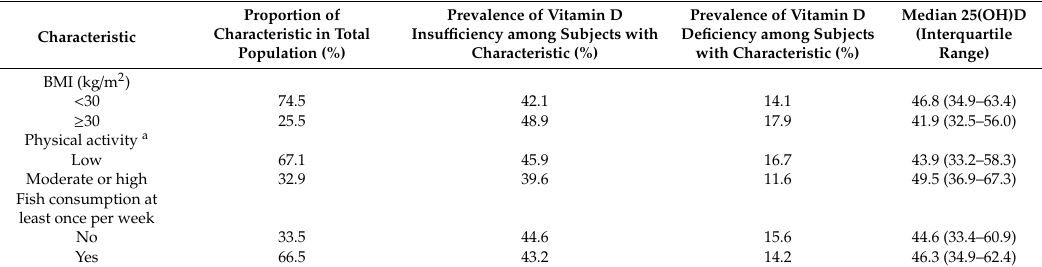
Figure 3. Dose–response relationship between 25(OH)D levels and respiratory disease mortality.